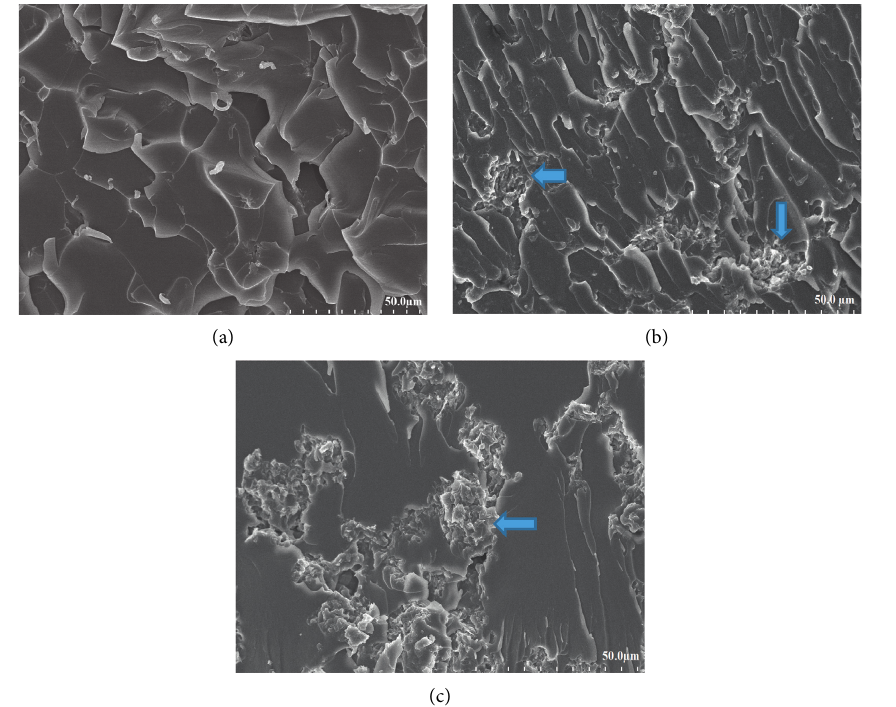
Figure 4: FE-SEM image of epoxy Epikote 240/nanoclay I.30E nanocomposite materials: (a) 1% wt nanoclay, (b) 3% wt nanoclay, and (c) 5% wt nanoclay. Table 5: Mechanical strength of nanocomposite epoxy Epikote 240/nanoclay I.30E material with different nanoclay I.30E